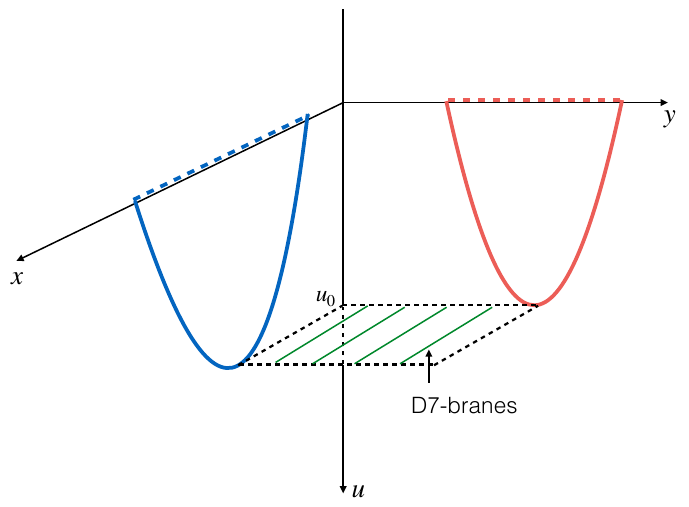
Figure 3 . The configuration of the fundamental string and the N D7 D7-branes. The blue line refers to the case that the open string is put in { x, u } plane i.e. parallel to the D7-branes. The red line refers to the case that the open string is put in { y, u } plane i.e. vertical to the D7-branes. The D7-branes are represented by the green